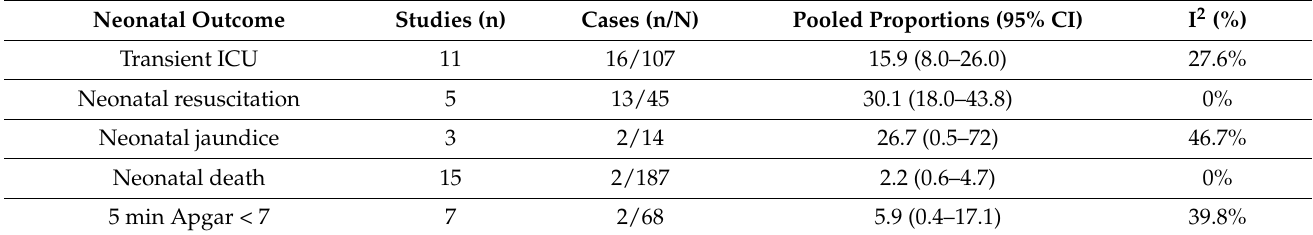
Table 6. Neonatal outcome expressed as mean ± standard deviation (SD) or in terms of pooled proportions with their 95% confidence intervals